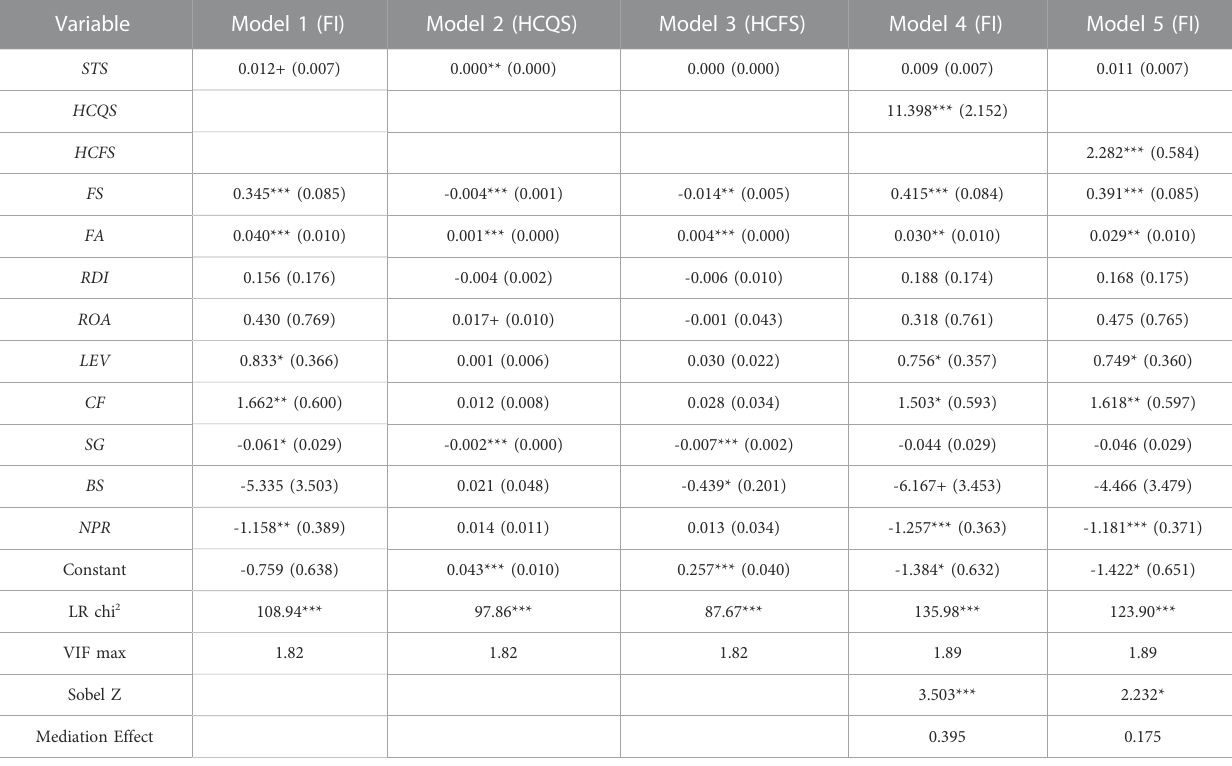
TABLE 7 Robust analysis-regression method.